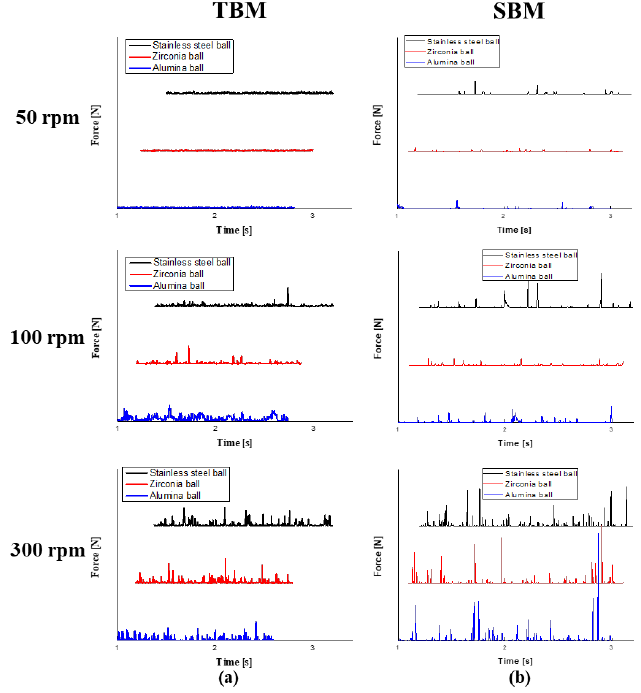
Figure 15. Milling force spectra of 50, 100, 300 rpm in both mills ( a ) TBM, and ( b ) SBM by DEM simulation.